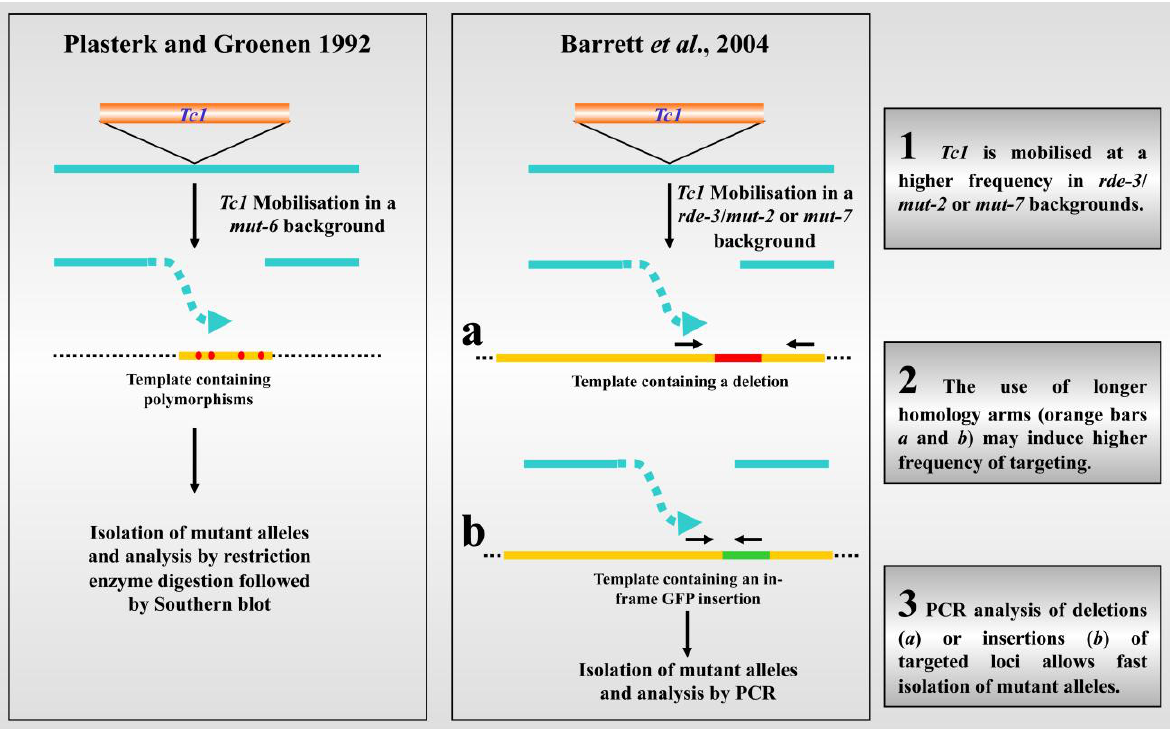
FIGURE 2. Diagram showing the improvements introduced by Barrett and coworkers to the method of gene conversion by Plasterk and Groenen. The first box shows a diagram that represents the technique developed by Plasterk and Groenen[40]. The second box represents the method by Barrett and coworkers[42]. The text boxes on the right-hand side highlight the three key improvements that made the method of Barrett and coworkers more effective. Blue bars represent genomic DNA. Orange bars represent exogenous DNA, homologous to the region to be targeted, used as a template to introduce changes in the genome. Arrows represent primers used for PCR analysis. Dotted black lines represent nonhomologous